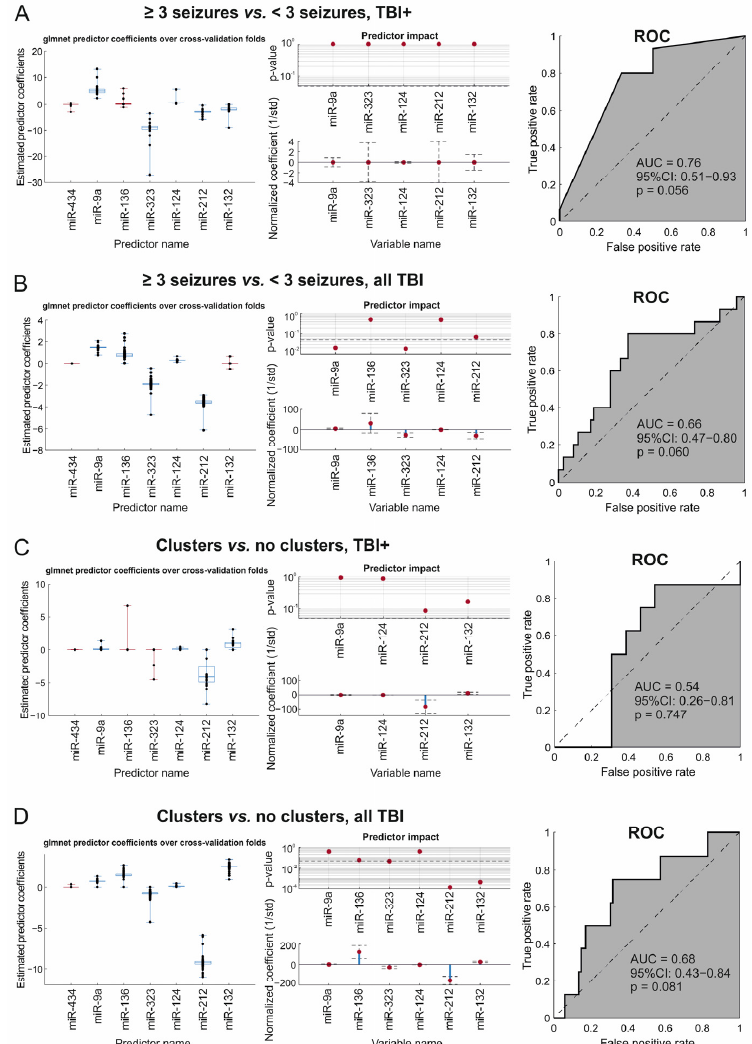
Figure 8. Elastic net regularized logistic regression (glmnet) analysis of plasma miRNA profile in epilepsy severity groups. ( A ) Left panel : Boxplots of predictor coefficients over cross-validation folds. The analysis defined miR-9a-3p, miR-323-3p, miR-124-3p, miR-212-3p, and miR-132-3p (blue boxplots) as the optimal set of miRNAs to separate TBI+ rats with ≥ 3 seizures/month ( n = 15) from TBI+ rats with <3 seizures/month ( n = 6). Due to having a coefficient of zero in most cross-validation folds, miR-434-3p and miR-136-3p were excluded (red boxplot). Center panel: p -value and normalized coefficient of each predictor in the standard logistic regression analysis. Right panel : Cross-validated ROC AUC was only 0.76 with a large confidence interval and p > 0.05. ( B ) The analysis defined miR-9a-3p, miR-136-3p, miR-323-3p, miR-124-3p, and miR-212-3p as the optimal set of miRNAs to separate TBI+ rats with ≥ 3 seizures/month ( n = 15) from all remaining TBI rats ( n = 75), but the ROC AUC was 0.66 with a large confidence interval and p > 0.05. ( C ) The analysis defined miR-9a-3p, miR-124-3p, miR-212-3p, and miR-132-3p as the optimal set of miRNAs to separate TBI+ rats with ( n = 8) or without ( n = 13) seizure clusters. The ROC AUC, however, was only 0.54 with a large confidence interval and a nonsignificant p -value ( p > 0.05). ( D ) The analysis defined miR-9a-3p, miR-136-3p, miR-323-3p, miR-124-3p, miR-212-3p, and miR-132-3p as the optimal set of miRNAs to separate TBI+ rats with seizure clusters ( n = 8) from all remaining TBI rats ( n = 82). The ROC AUC was 0.68, however, with a larger confidence interval and p > 0.05. Abbreviations: AUC, area under the curve; CI, confidence interval; ROC, receiver operating characteristics; TBI, traumatic brain injury; TBI+, rats with epilepsy; TBI − , rats without